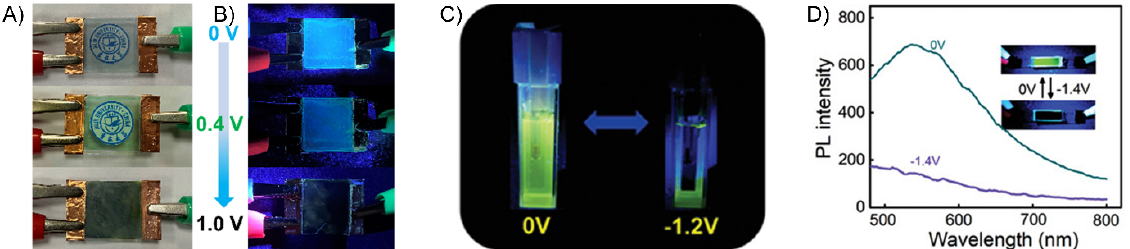
Figure 19. Operating dual-display device: electrochromic ( A ) and electrofluorochromic ( B ) devices developed from P16b with different applied potentials. Reproduced with permission from ref. [152]. Copyright 2021 Elsevier. ( C ) Photograph of P27 in water irradiated at 410 nm with an applied potential of 0 V (left) and − 1.2 V (right). ( D ) Fluorescence spectrum of dual-mode device of P27 with an applied potential of 0 and − 1.4 V and photographs of operating device (inset). ( C , D ) Reproduced with permission from ref. [172]. Copyright 2022 John Wiley and Sons.